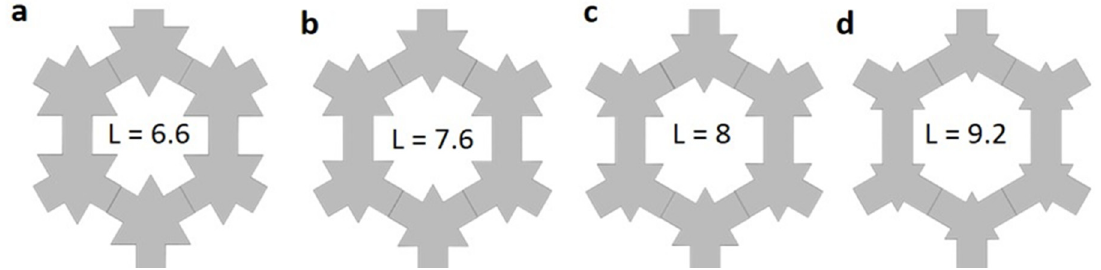
Figure 2. Schematic diagram showing the change in the snowflake structure with various neck lengths of ( a ) 6.6 nm, ( b ) 7.6 nm, ( c ) 8 nm, and ( d ) 9.2 nm.